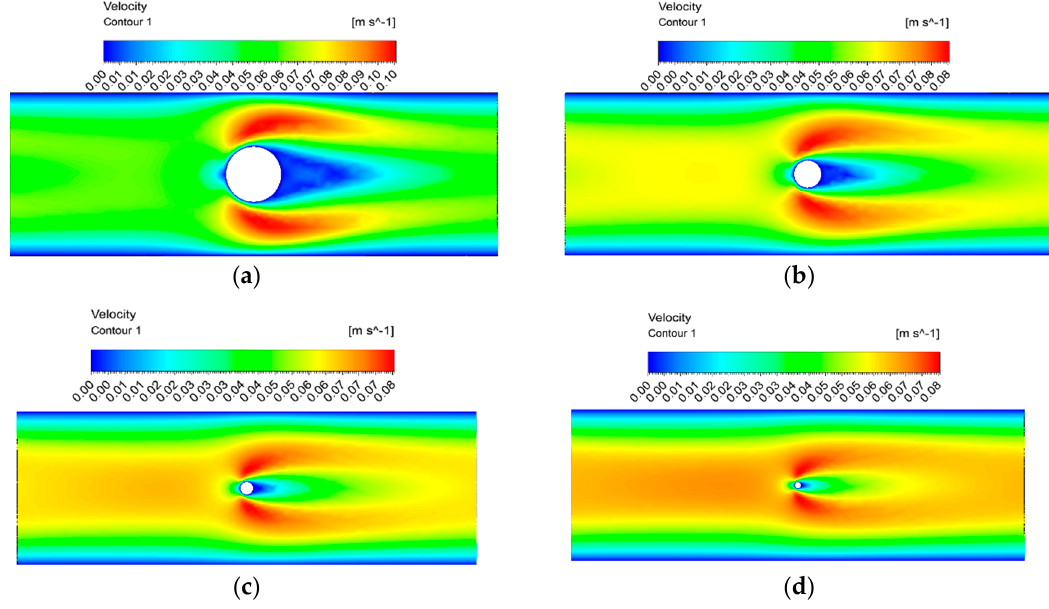
Figure 8. Contours of velocity in the main flow direction for the super velocity of 0.04 m/s (red: high, blue: low). ( a ) d / a = 2; ( b ) d / a = 1; ( c ) d / a = 0.5; ( d ) d / a = 0.25.